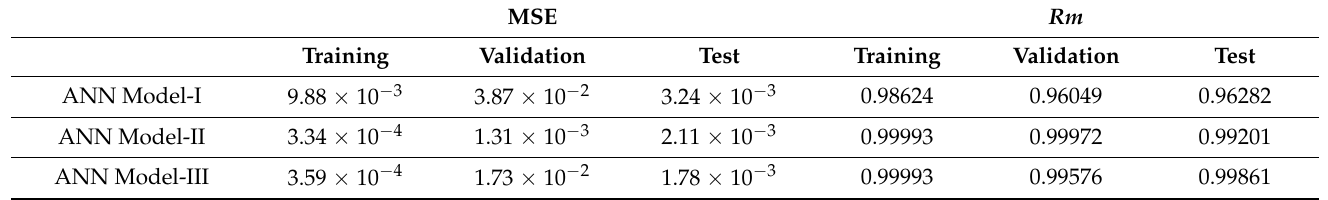
Table 22. Performance results for ANN models.